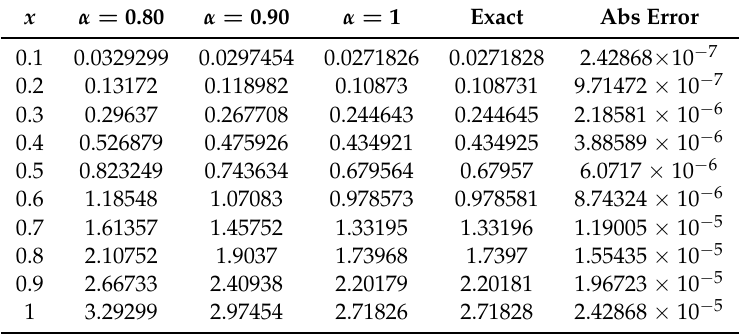
Table 10. Third order approximate results for different values of α at t = 1 of Example 2.